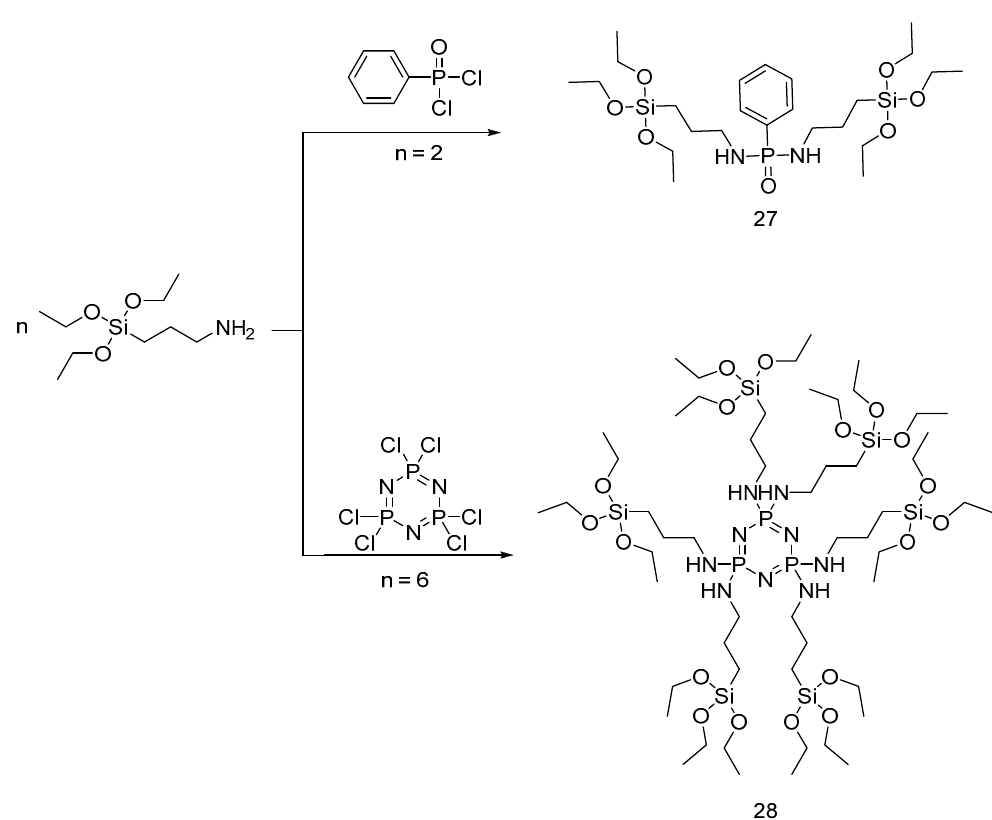
Figure 19. Representative schematic synthesis of precursors ( 27 ) and ( 28 ).